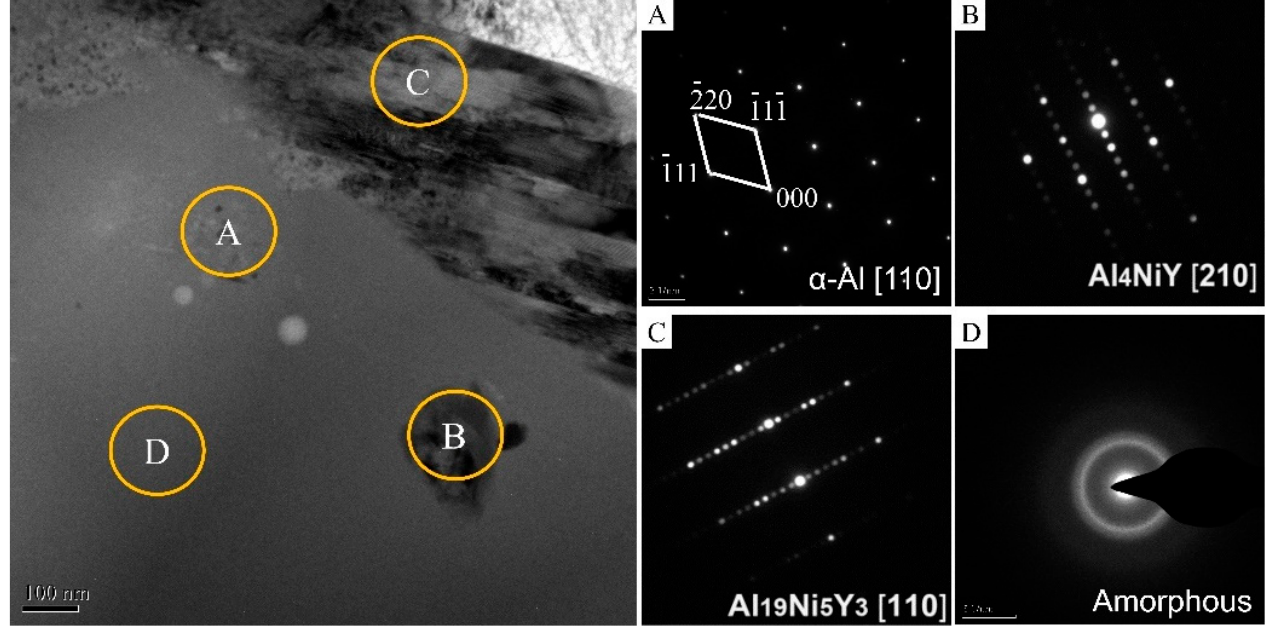
Figure 3. The bright-field TEM images and corresponding selected-area electron diffraction (SAED) patterns for the coating. ( A ) α -Al phase; ( B ) Al 4 NiY phase; ( C ) Al 4 NiY phase and ( D ) Amorphous phase.